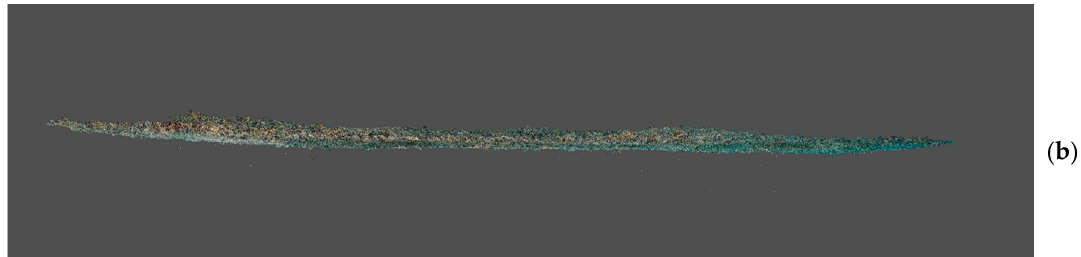
Figure 9. Profile views of bowled uncalibrated model ( a ) versus model corrected through ground control process ( b ).